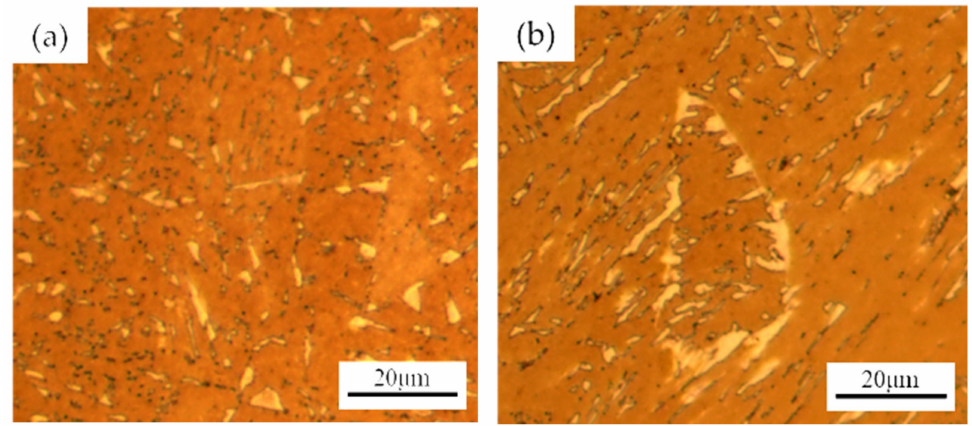
Figure 4. OM of CGHAZ and ICCGHAZ etched by LePera solution. ( a ) CGHAZ; ( b ) ICCGHAZ.